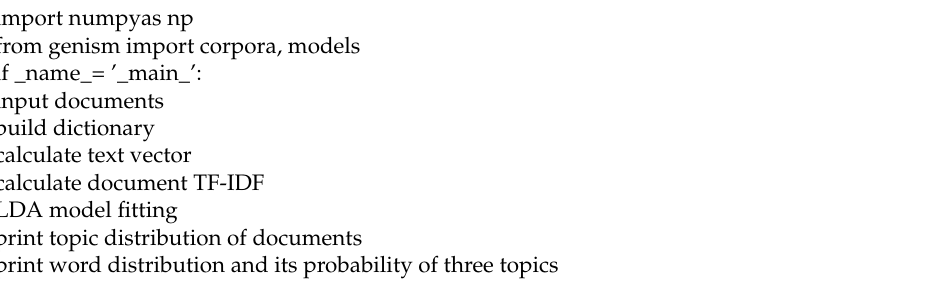
Table 3. The Python pseudocode of the process of LDA topic